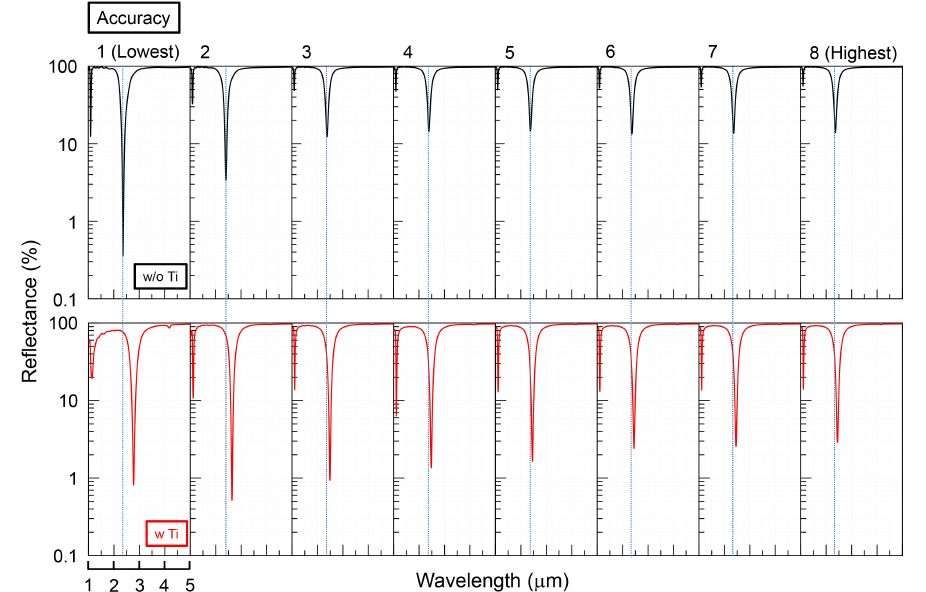
Figure 6. FDTD simulations with or without Ti adhesion layer (5 nm thickness) at several meshing accuracy levels (8 was the highest). The diameter of the disc is 300 nm, period is 1200 nm, SiO 2 thickness is 50 nm; Palik’s data were